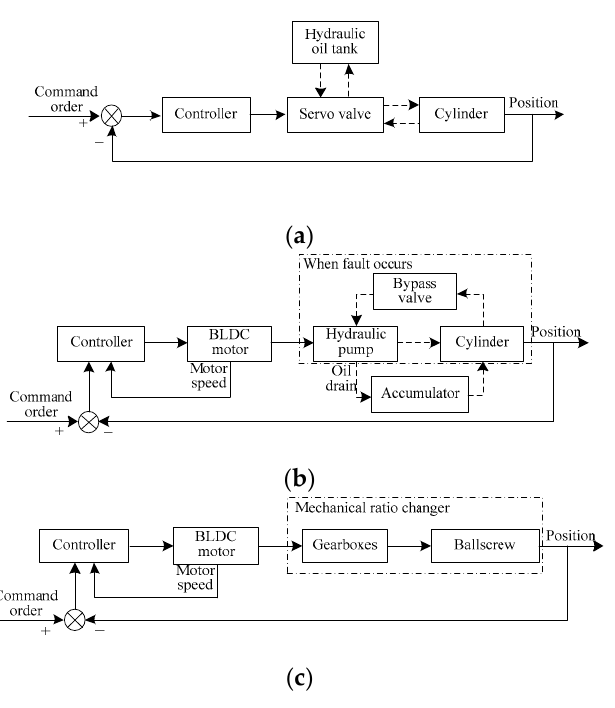
Figure 3. Schematic diagrams of three types of actuators. ( a ) EHSA; ( b ) EHA; ( c ) EMA.